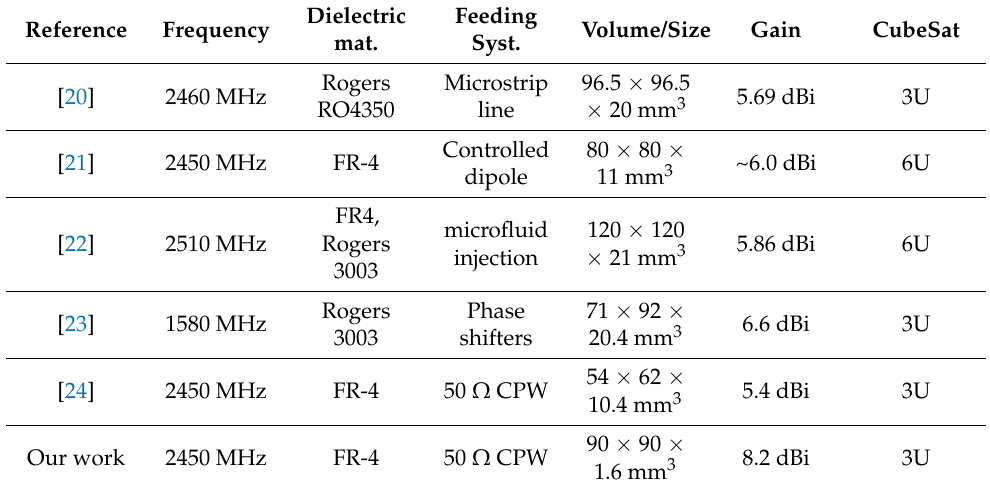
Table 7. A brief comparison with literature works on S-band metasurface/metamaterial